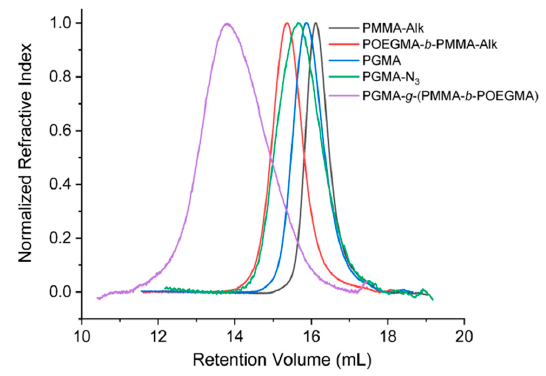
Figure 4. Molecular weight distribution of the block copolymer brush and all its precursors.